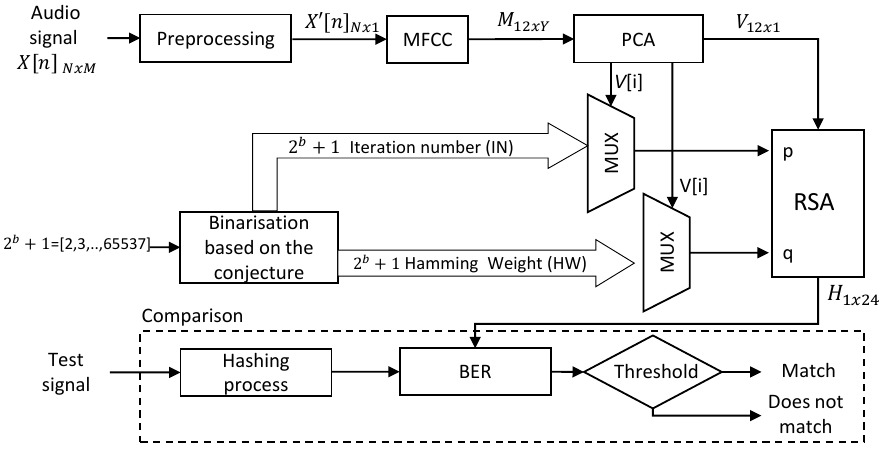
Figure 1. Block diagram of the proposed robust speech hashing